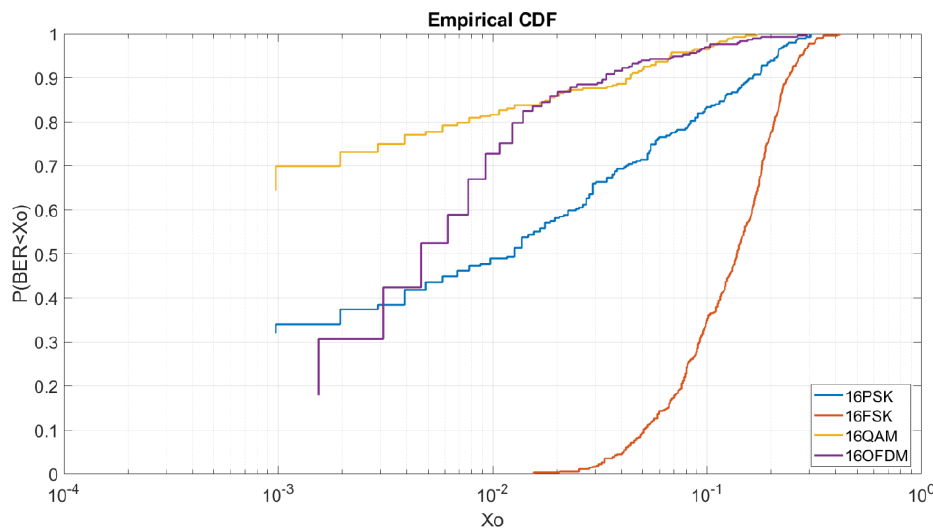
Figure 13. BER vs. E b / N 0 = 8 dB M = 16.